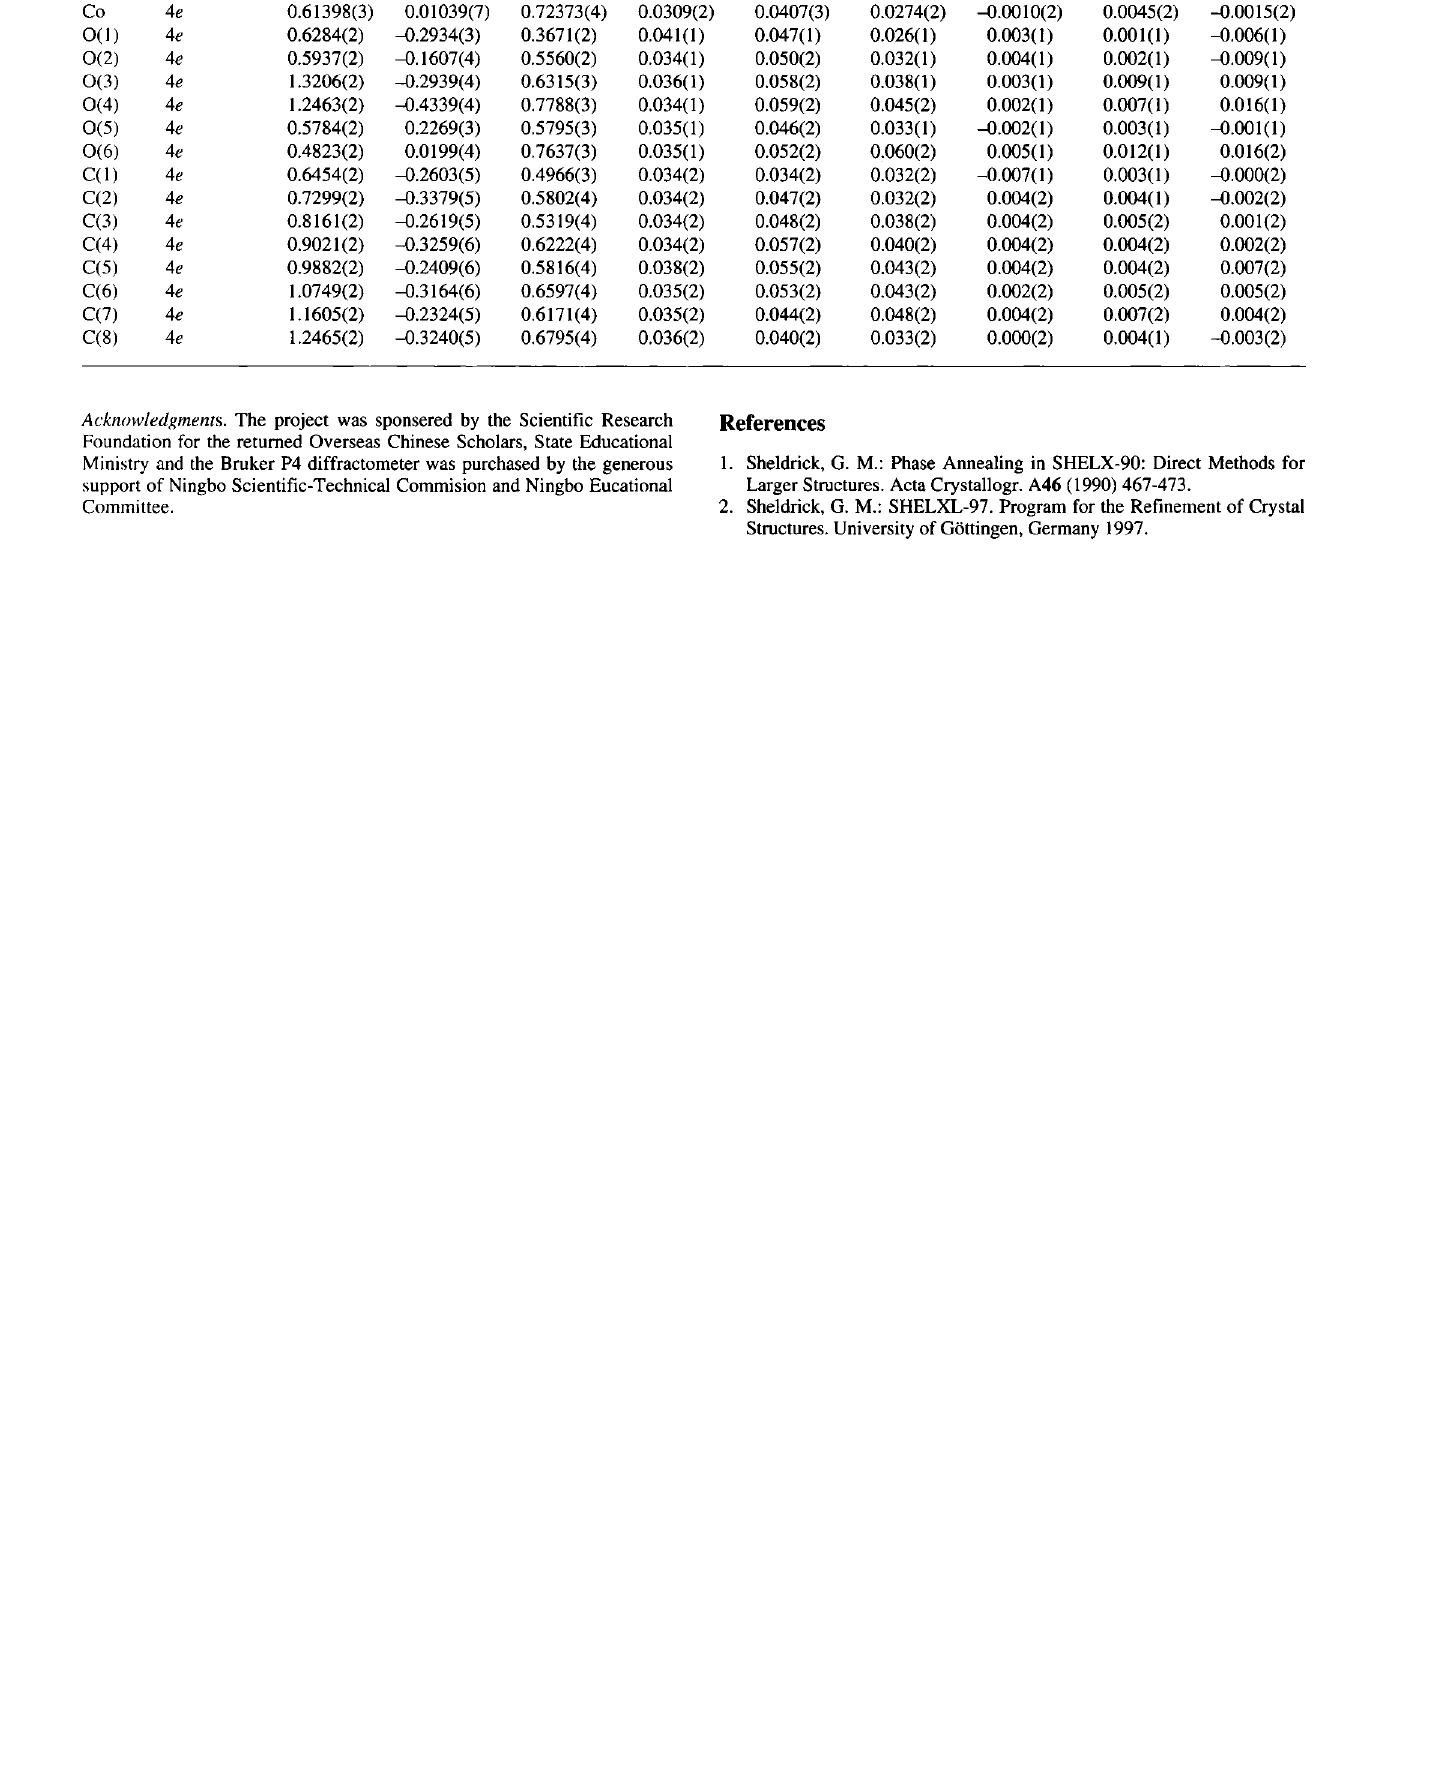
Table 3. Atomic coordinates and displacement parameters (in Ä 2